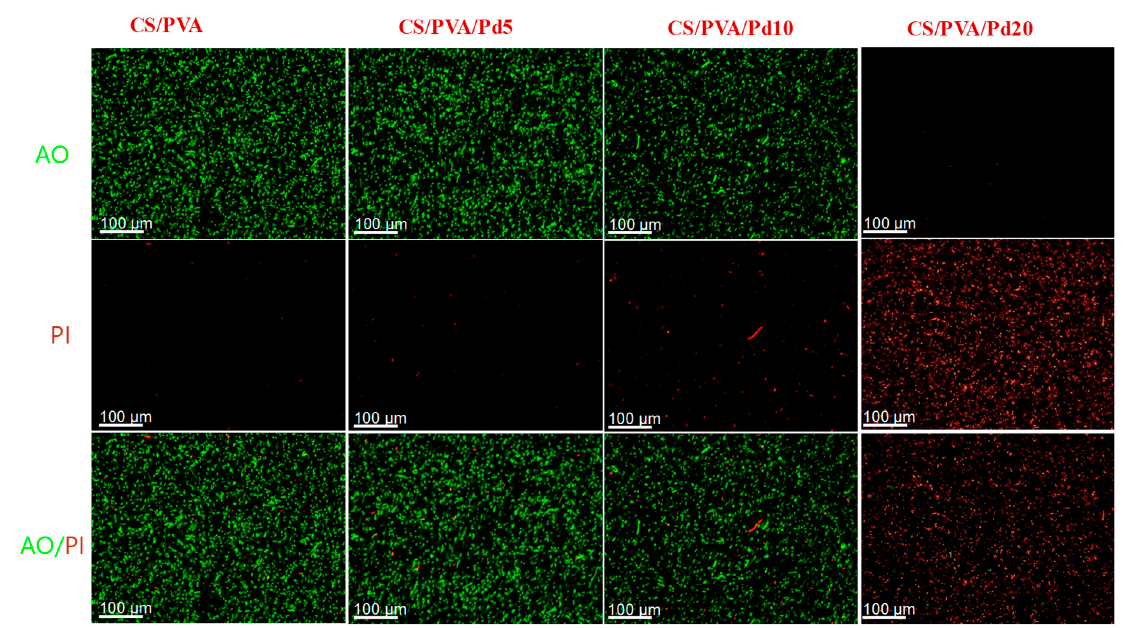
Figure 10. Anti-bacterial performance of CS/PVA and CS/PVA/Pd dressings.